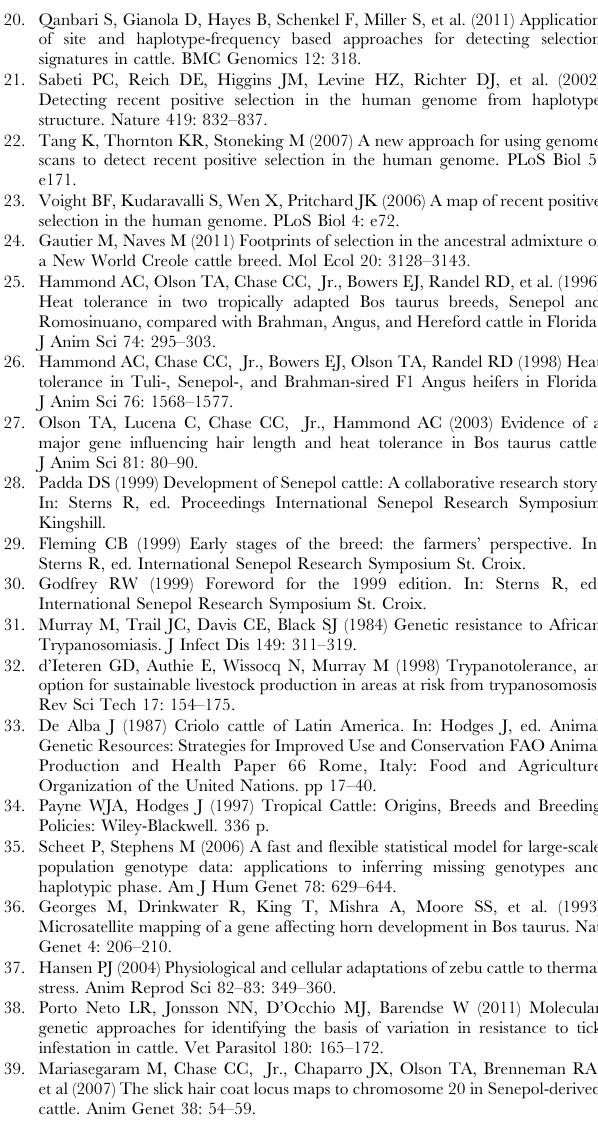
Figure S3 Unsupervised hierarchical clustering results with different number of clusters of 506 individuals genotyped for 47365 SNPs. The 506 individuals, comprising 30 SEN individuals randomly chosen, were analyzed with an inferred number of clusters K = 2 (A), K =3 (B) and K =4 (C). For each individual, the proportion of each cluster (y) which were interpreted as representative of EUT, AFT and ZEB ancestries are plotted in blue, red and green, respectively. Figure S4 Empirical distribution of SEN, EUT and ZEB iHS scores. Table S1 List of population symbols, names and number of individuals.